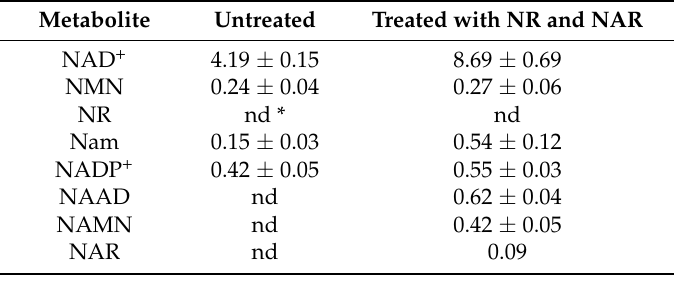
Figure 3. Detection of deamidated NAD + intermediates in human cell extracts. Characteristic region of 1 H NMR spectrum of cell extract obtained from HEK293 cells cultivated in the presence of Nam, NR and NAR. The upper panel spectrum represents 10 × vertically enlarged the lower panel spectrum. nt = 8192. Table 2. The intracellular NAD + and its major intermediates content (nmol/mg protein) in HEK293 cells.